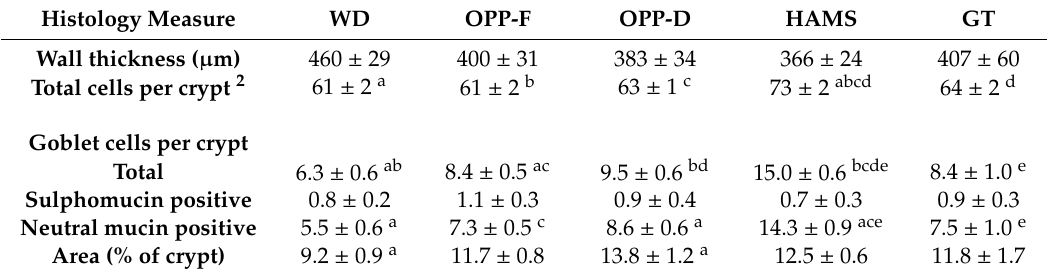
Table 6. E ff ects of dietary treatment on colonic tissue goblet cell numbers 1